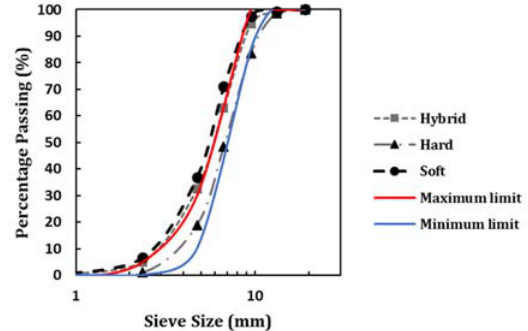
Figure 2. Sieve analysis of BPW.